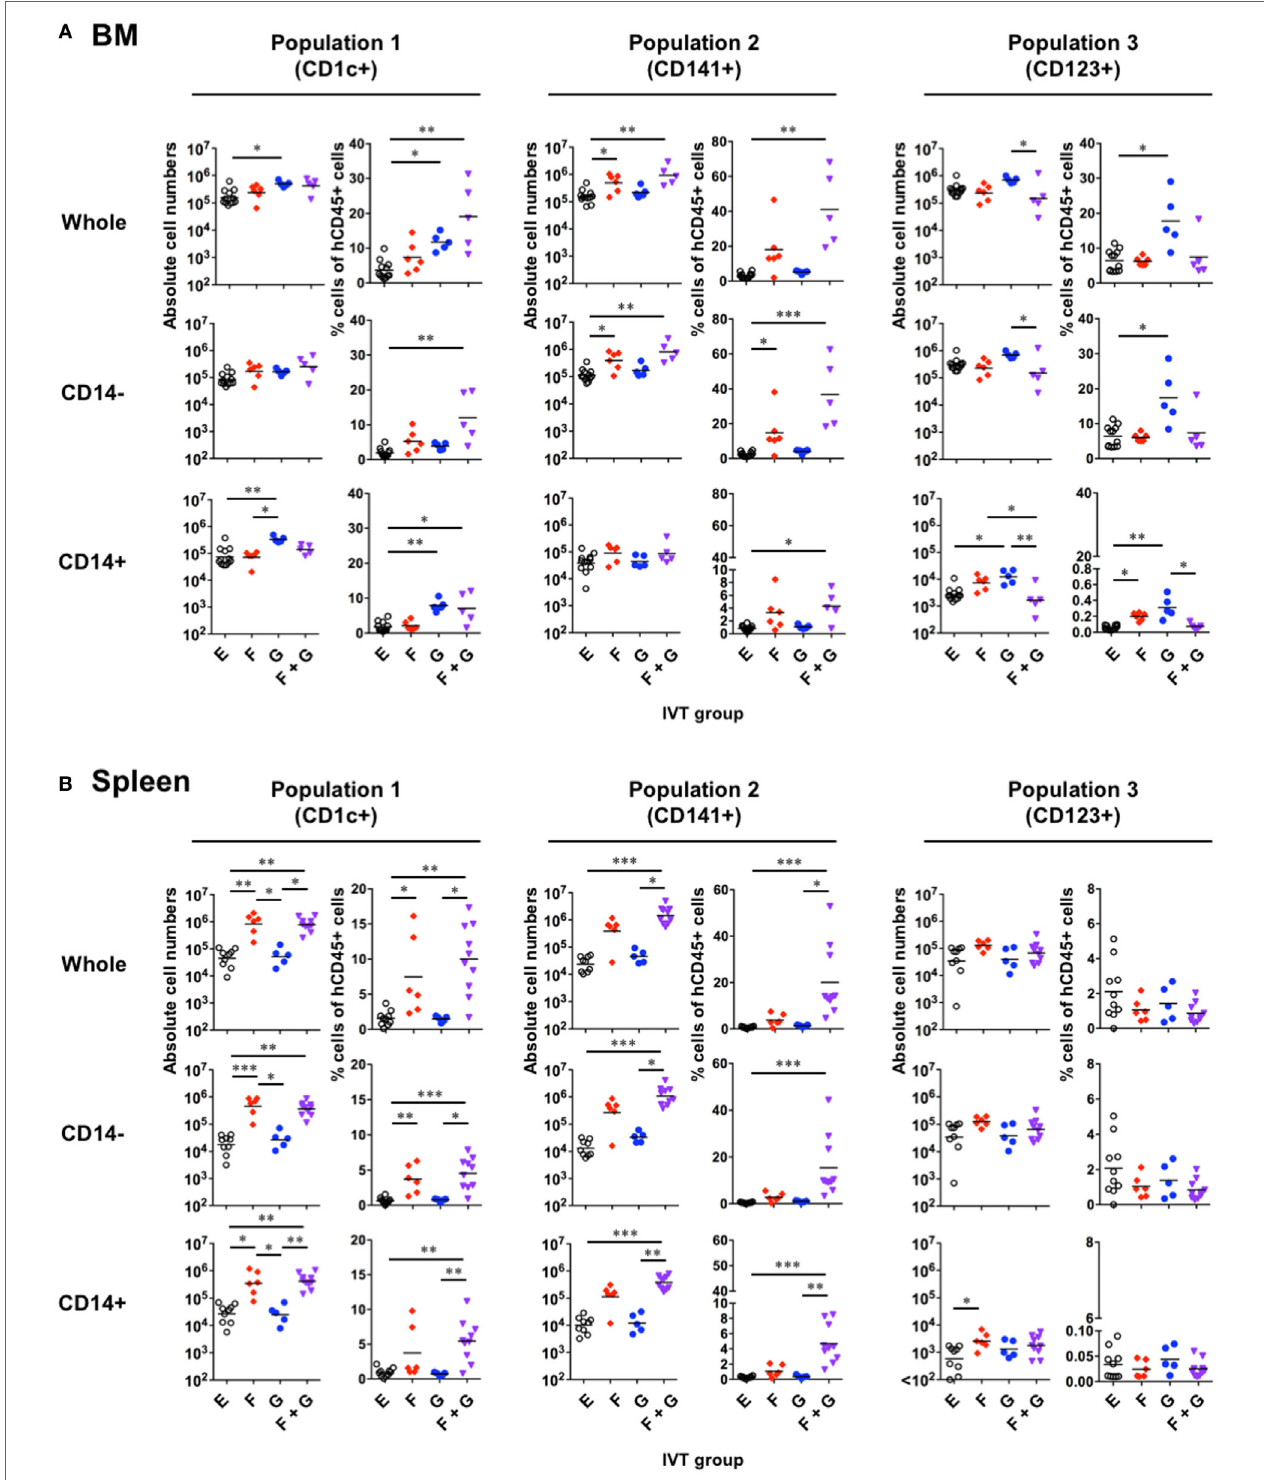
FigUre 4 | Reconstitution of putative human dendritic cell populations in hNOJ mice following in vivo transfection (IVT). Cells were prepared from the bone marrow (BM) and spleen of each IVT group. (a,b) Comparison of the absolute cell numbers (left panels) and the percentages (right panels) of CD1c + population (Population 1), CD141 + population (Population 2), and CD123 + population (Population 3) among all hCD45 + cells in the BM (a) and spleen (b) . Data are the individual values with the geometric means of the absolute cell numbers and the means of the percentages ( n = 5–12 per group). Significant differences (* P < 0.05, ** P < 0.01, *** P < 0.001) were determined by the Kruskal–Wallis test followed by the Dunn’s multiple comparisons test.